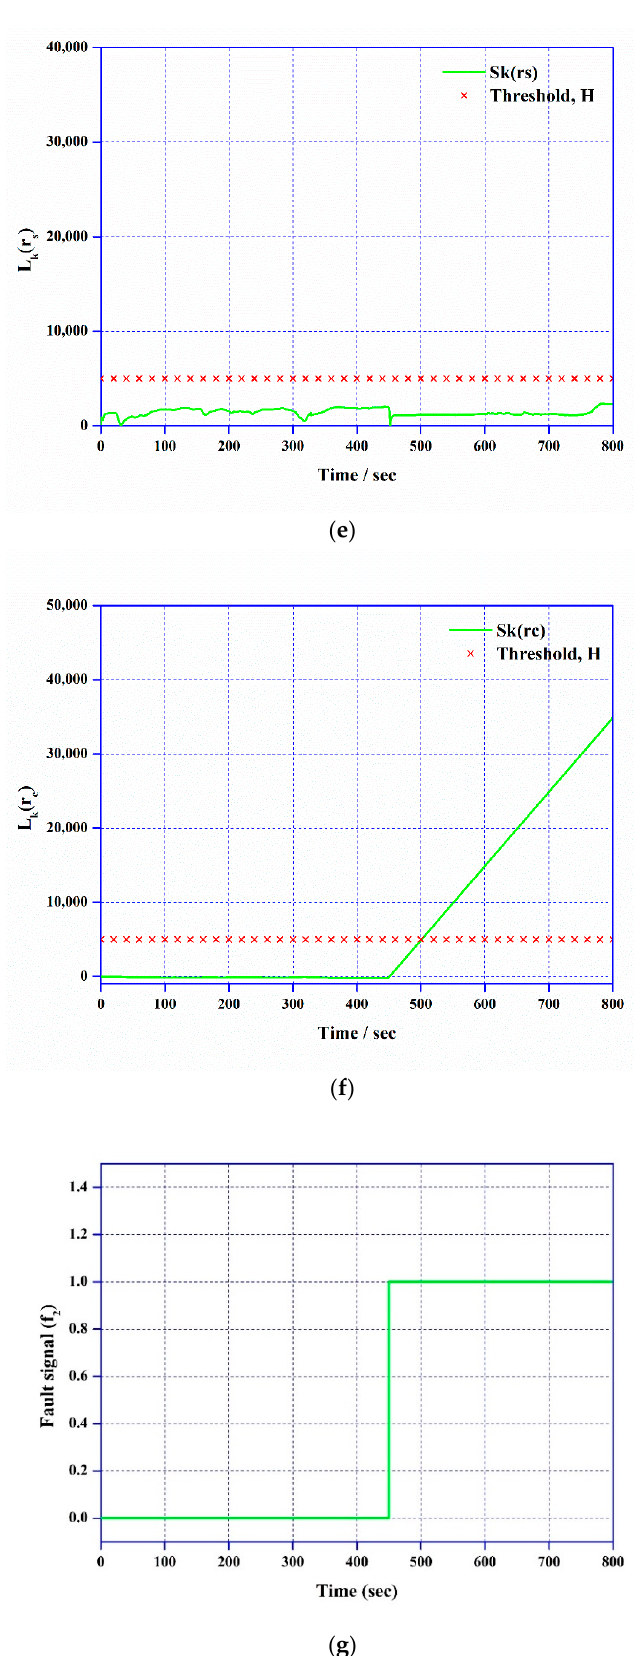
Figure 8. Sensor measurements, residuals, and detection results in coolant inlet stuck fault of